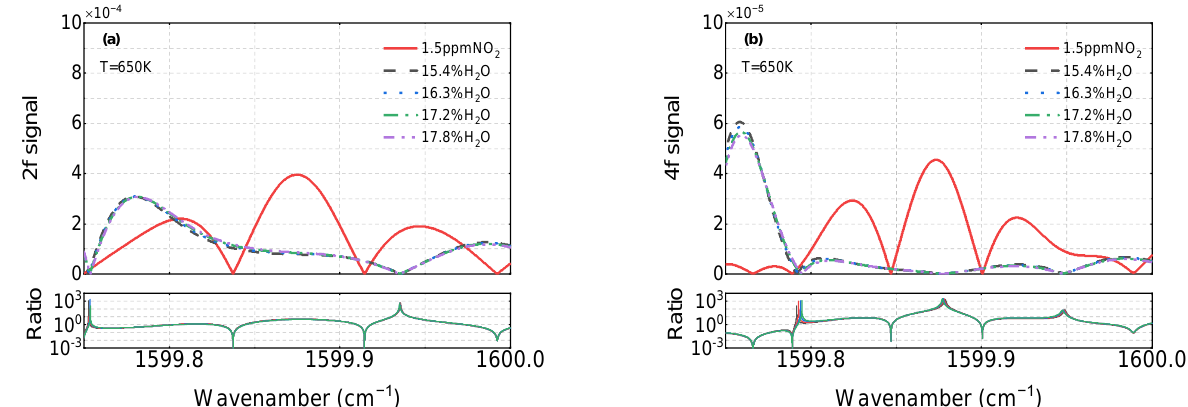
Figure 5. Simulation of 1.5 ppm NO 2 in 15.4–17.8% H 2 O and the corresponding second harmonic ( a ) and fourth harmonic ( b ). P = 1 atm, L = 157.5 cm, T = 650 K.